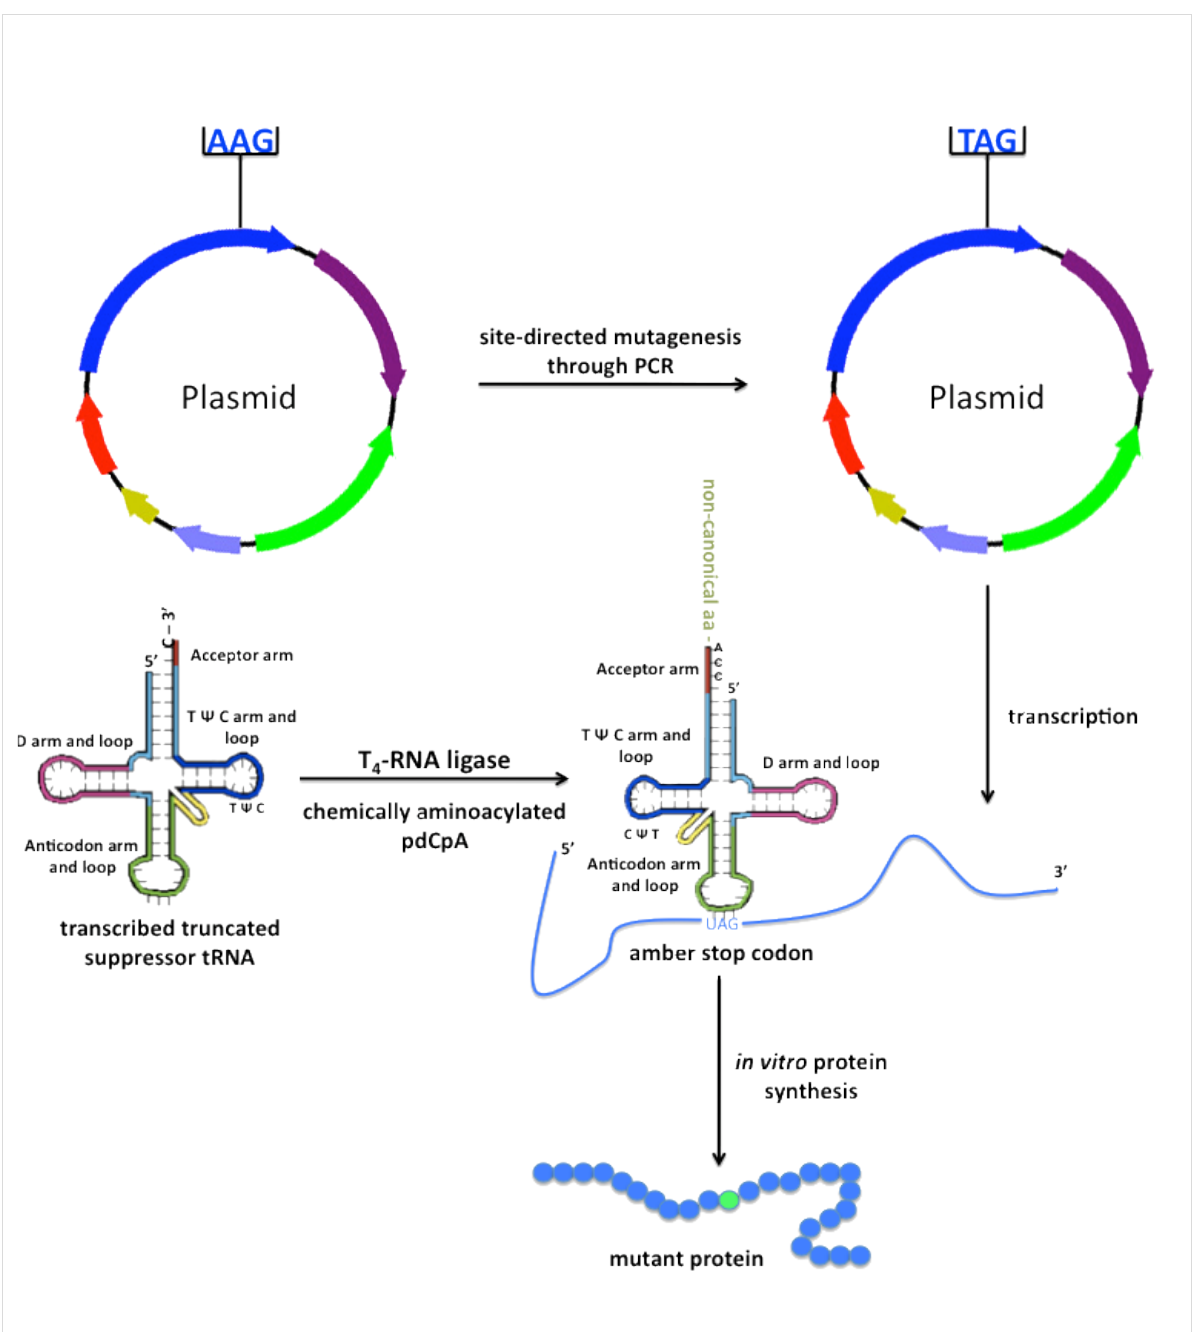
Figure 1: General strategy of using a chemically aminoacylated suppressor tRNA and an in vitro translation system to produce proteins which contain non-canonical amino acids (based on Noren et al. [1]). An amber stop codon, TAG, is introduced site-specifically into the protein-encoding gene, replacing an amino acid-encoding codon. The hybrid dinucleotide pdCpA is chemically aminoacylated with the non-canonical amino acid of interest and ligated to the appropriately truncated suppressor tRNA (tRNA-CA). Non-natural mutant proteins are produced by means of an in vitro protein syn- thesis